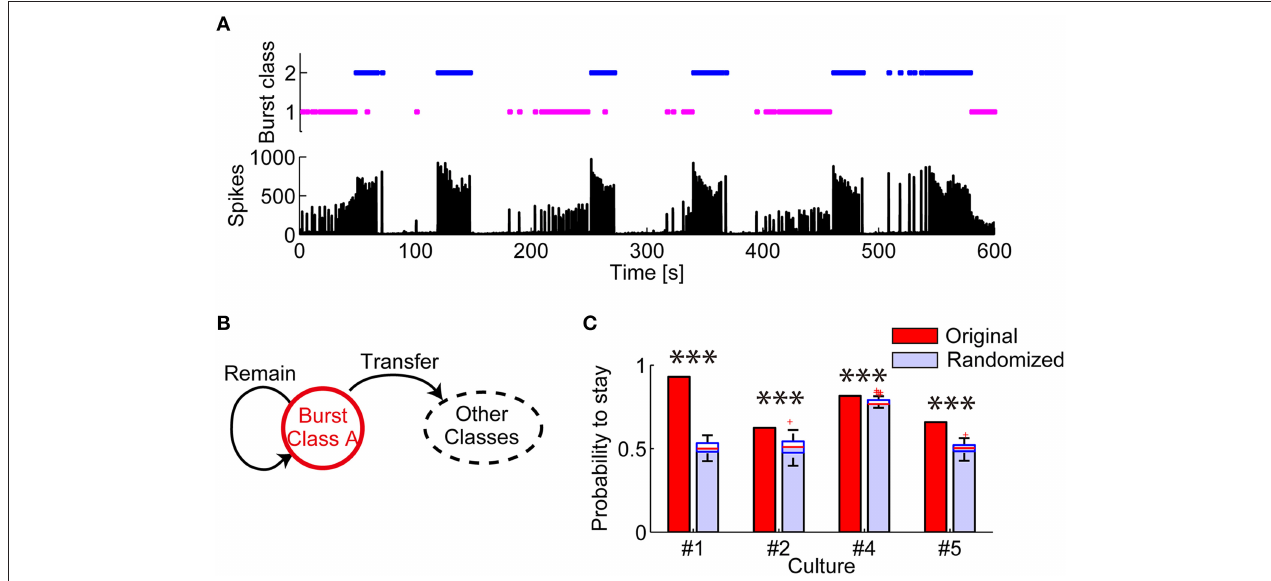
FIGURE 4 | Evaluation of consecutiveness in appearance of burst spatiotemporal patterns classes. (A) (Top) Periods in which each class of bursts appeared. (Bottom) Number of array-wide spikes through the whole recording. (B) Schematic illustration of the transition between multiple burst classes. The probability of “remaining” was evaluated. (C) Probability that the same class of bursts appeared in succession. Randomized data was generated by randomly shuffling original data. The red lines in randomized data indicate the median of the probabilities. The blue boxes are ranges from the 25th percentiles to the 75th percentiles. The whiskers are the ranges of the all probabilities excluding outliers (the red crosses). One-sample Wilcoxon signed-rank test. *** p < 0.001 .